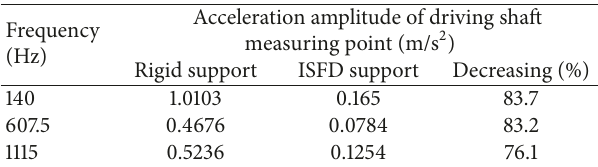
Table 2: Vibration reduction with different supports (driving